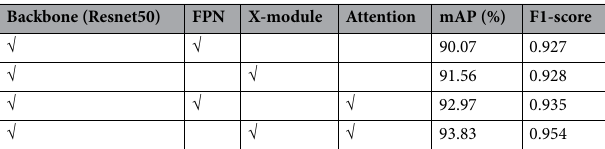
Table 3. Results of ablation